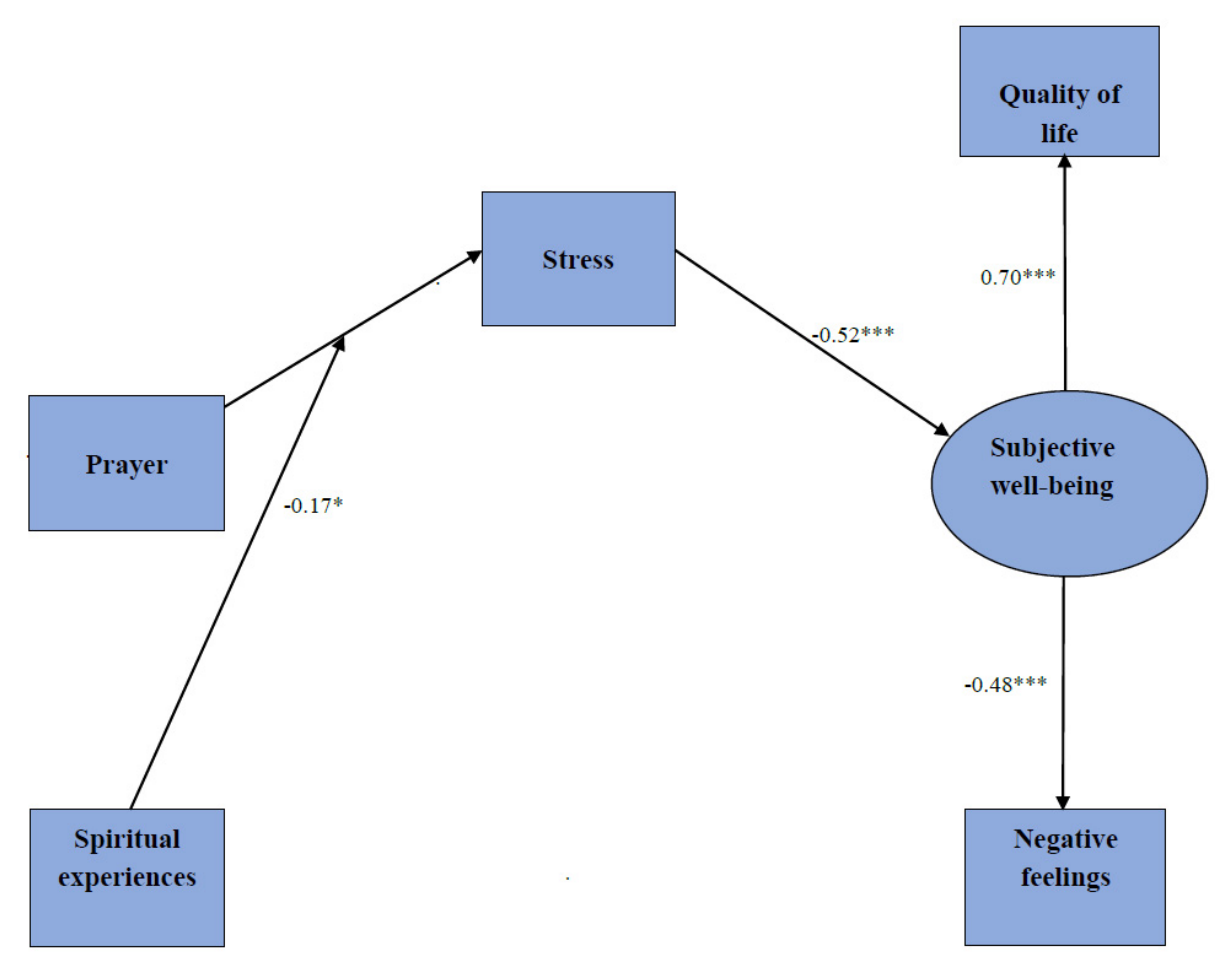
Figure 1. Research model with path analysis results. Note . The standardized regression coefficients are presented. * p < 0.05, *** p < 0.001. (Source: the Author).